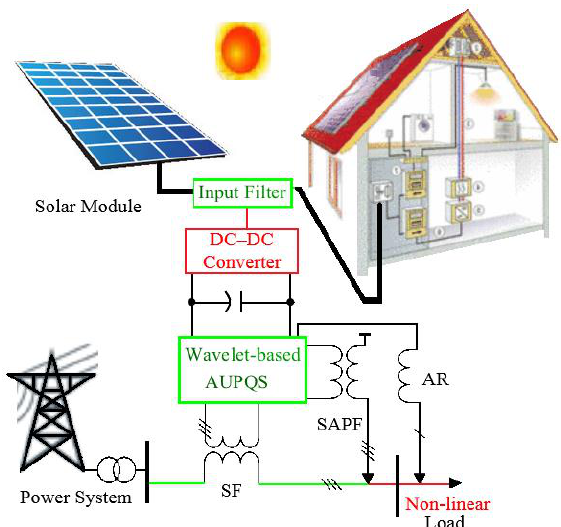
Figure 1. The proposed wavelet-based advanced universal power quality conditioning system (AUPQS) and the input filter within an integrated photovoltaic (PV) system.